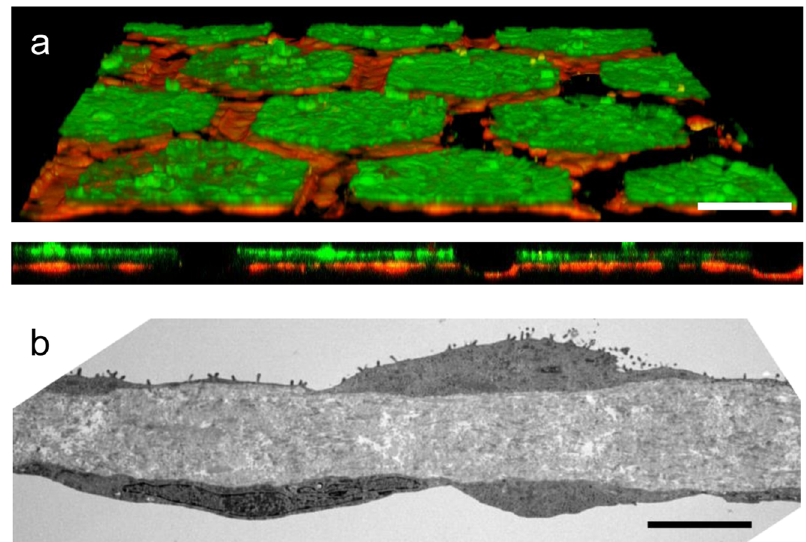
Fig. 6 Air – blood barrier reproduction. a Confocal pictures (perspective view and cross-section) of a coculture of hAEpC (E-Cadherin in green) with human primary endothelial cells (Rfp-label in red) on the hexagonal mesh with the CE membrane. Scale bar: 100 µ m. b TEM picture of hAEpC type I-like cells in coculture with human lung endothelial cells at day 4. Scale bar: 5 µ